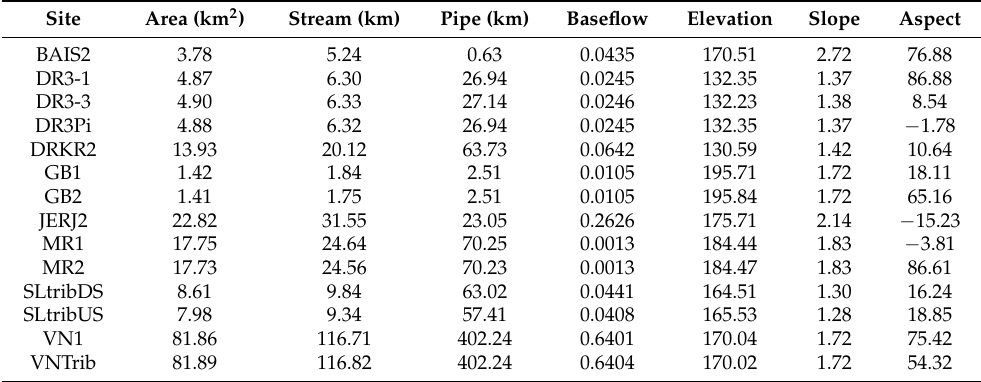
Table 1. Loggershed hydrology and pipes variables for study